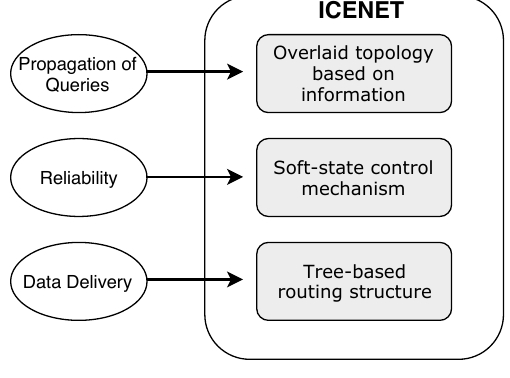
Figure 3. Information Centric protocol for sEnsor NETworks (ICENET)